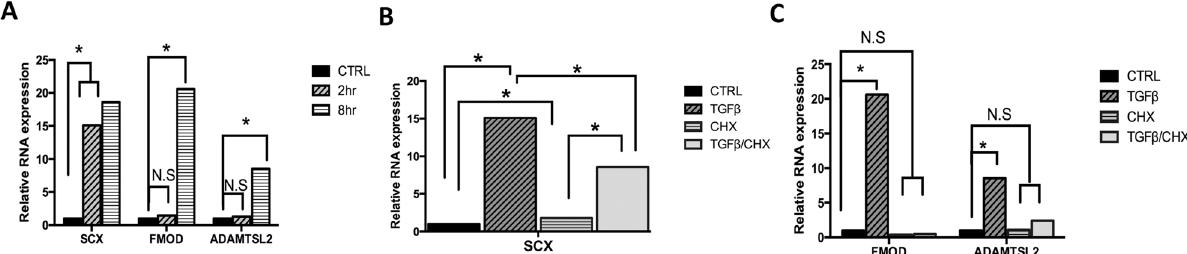
Figure 1. TGF-β regulates expression of fibrous tissue markers. ( A ) Primary sclerotome was treated with vehicle control or TGFβ1 for 2 h or 8 h. qPCR was used to determine the relative levels of Scx, Fmod